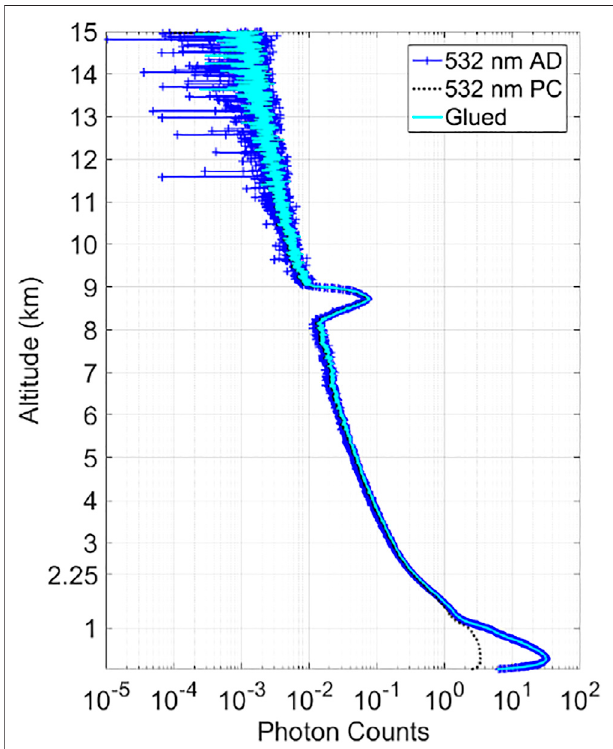
FIGURE 4 | The pro fi les of AD mode data, PC mode data and glued